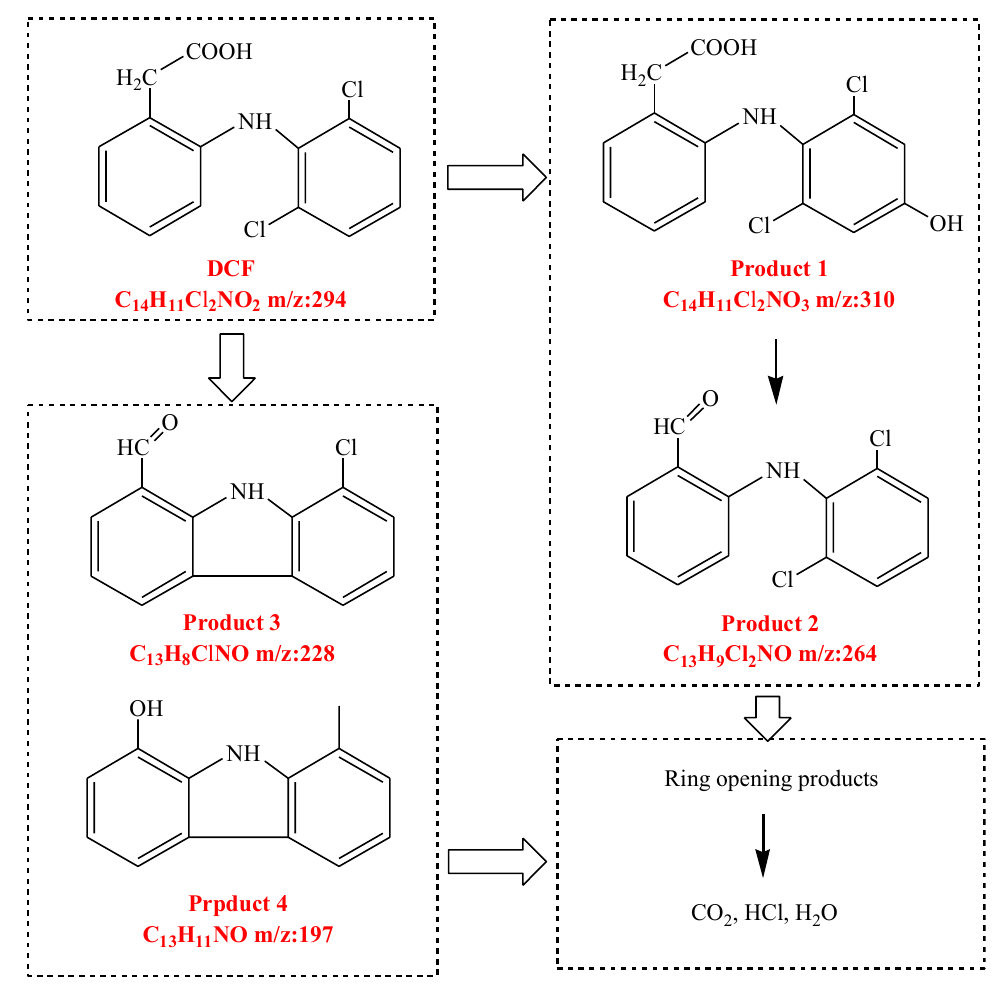
Fig. 12 Possible degradation pathways of DCF in WPBC